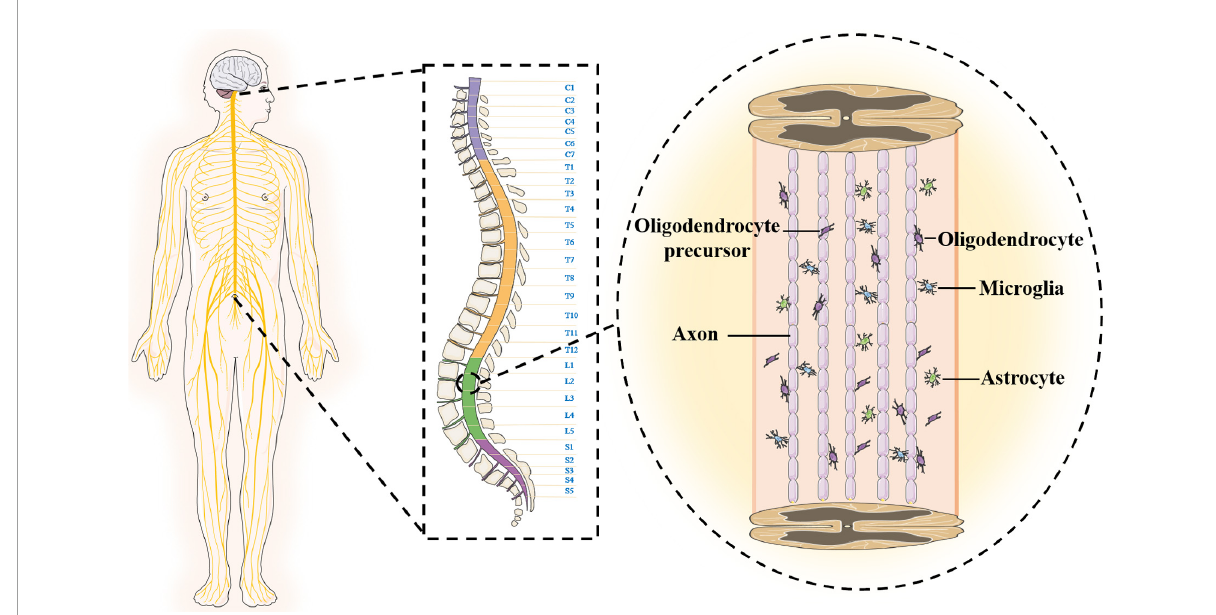
FIGURE1 The structural characteristics of spinal